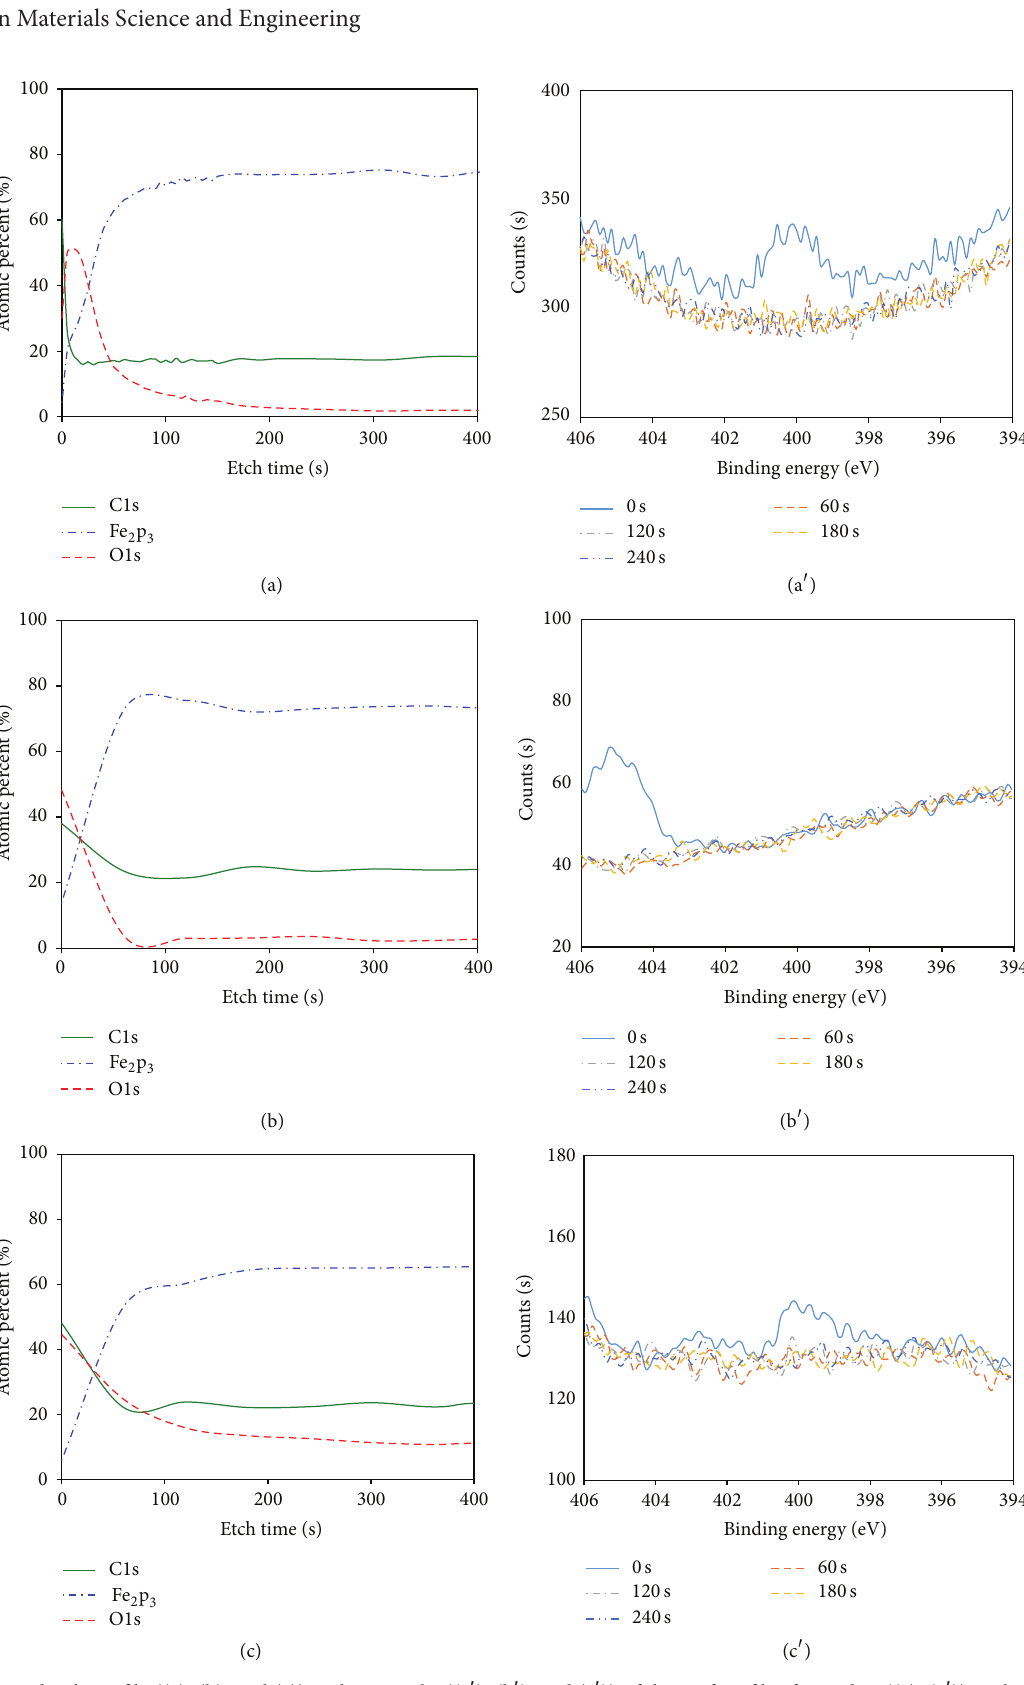
Figure 10: XPS depth profile ((a), (b), and (c)) and N1s peaks ((a 󸀠 ), (b 󸀠 ), and (c 󸀠 )) of the surface film formed in ((a), (a 󸀠 )) 100k ppm NO 2− + tap water, ((b), (b 󸀠 )) 100kppm TEA + tap water, and ((c), (c 󸀠 )) 1kppm NO 2− + 2.5k ppm TEA + tap